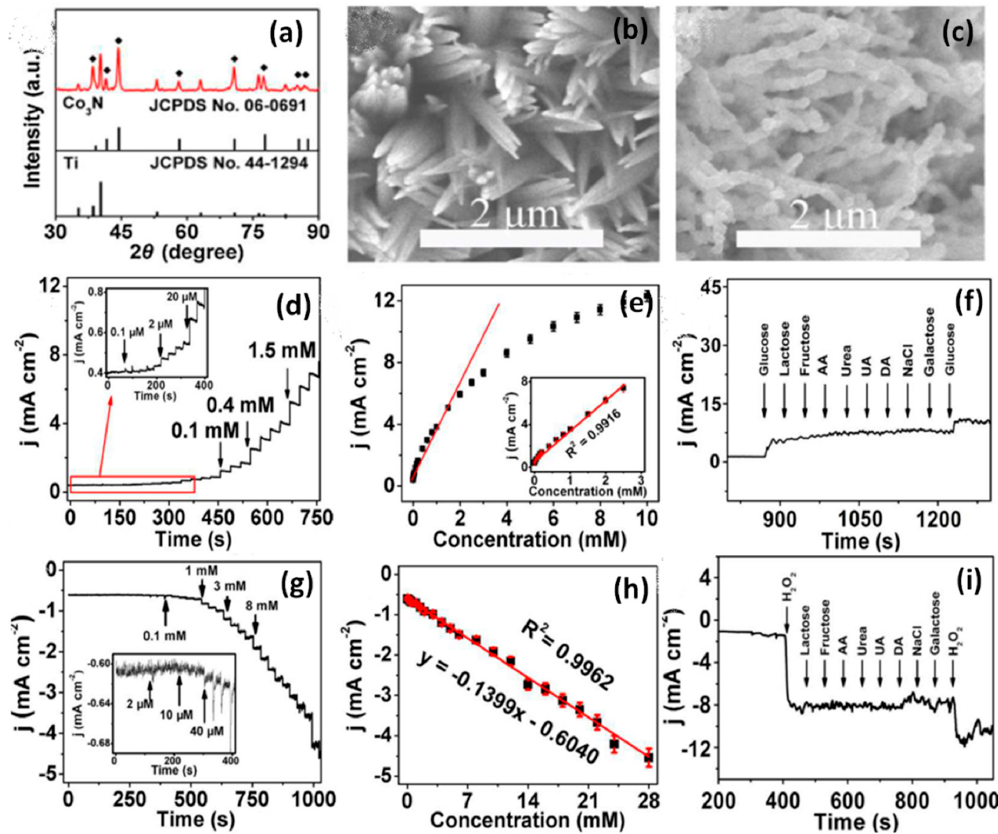
Figure 2. Co 3 N NW / TM: ( a ) XRD pattern; ( b and c ) SEM images of Co (Co(OH) 2 / TM; ( d ) ampherometric i-t response of Co 3 N NW / TM at 0.55 V (vs Hg / HgO with successive addition of glucose with varying concentration from 20 µ M to 5.5 mM); ( e ) corresponding calibration curve of Co 3 N NW / TM for the detection of glucose; ( f ) interference studies in the presence of glucose; ( g ) ampherometric i-t response of Co 3 N NW / TM at 0.55 V (vs Hg / HgO with successive addition of H 2 O 2 with varying concentration from 20 µ M to 5.5 mM); ( h ) corresponding calibration curve of Co 3 N NW / TM for detection H 2 O 2 ; ( i ) interference studies in the presence of H 2 O 2